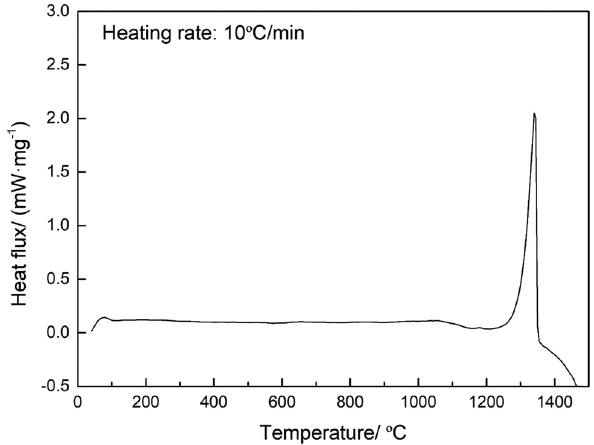
Figure 5: DSC heating curve of as - cast René 65.